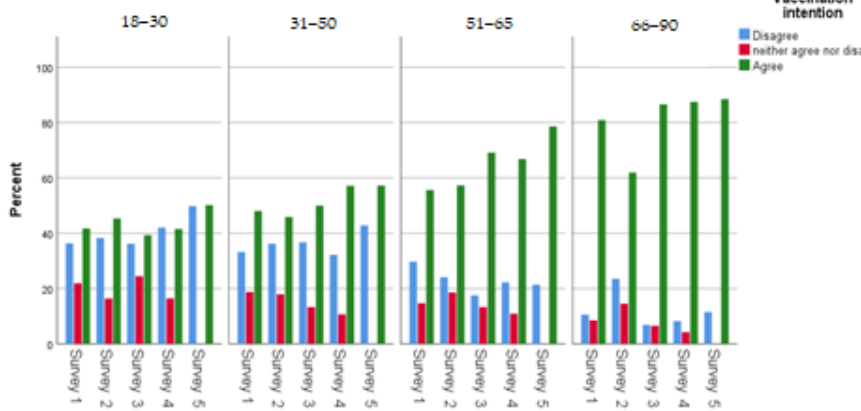
Figure 4. Age groups and vaccination intention across the surveys.